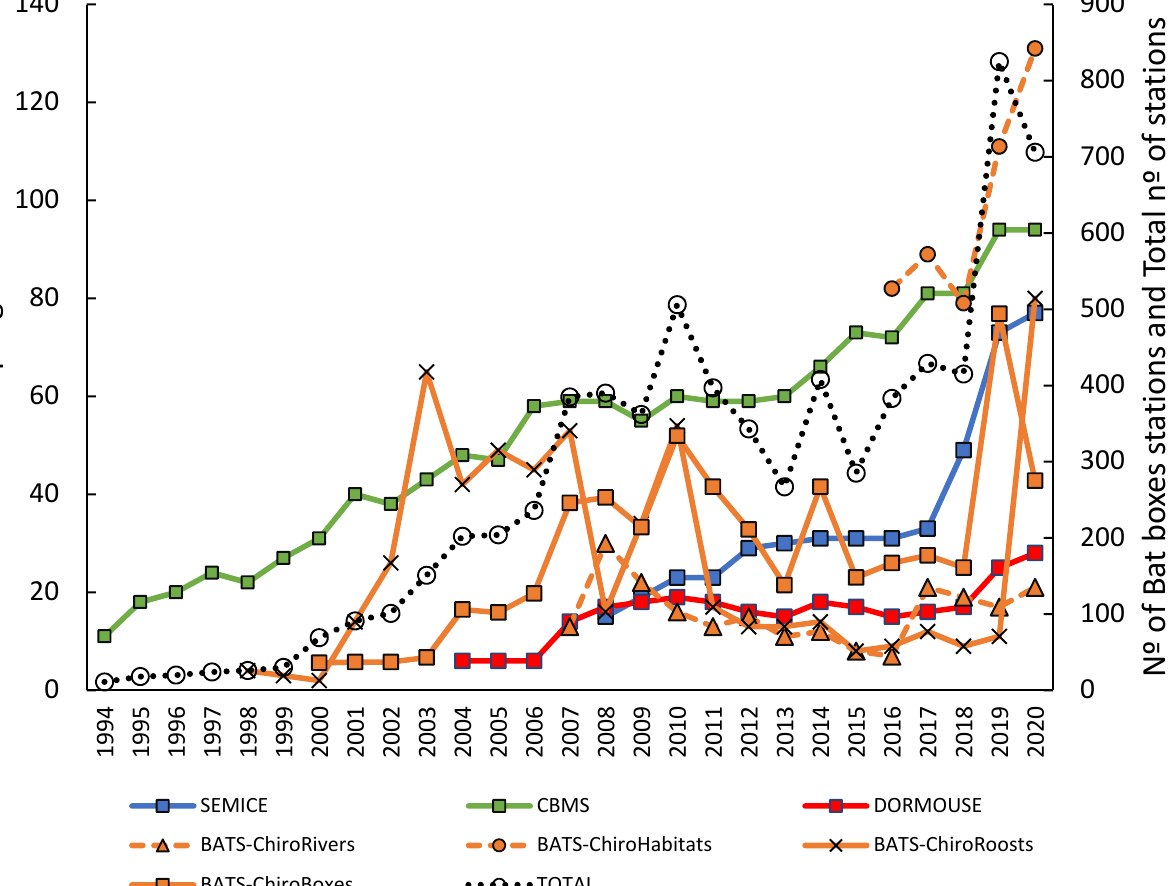
Figure 2. Number of sampling stations per monitoring programme along the study period (1994–2020). The right axis shows the number of bat boxes (the ChiroBoxes protocol), and the total number of stations.